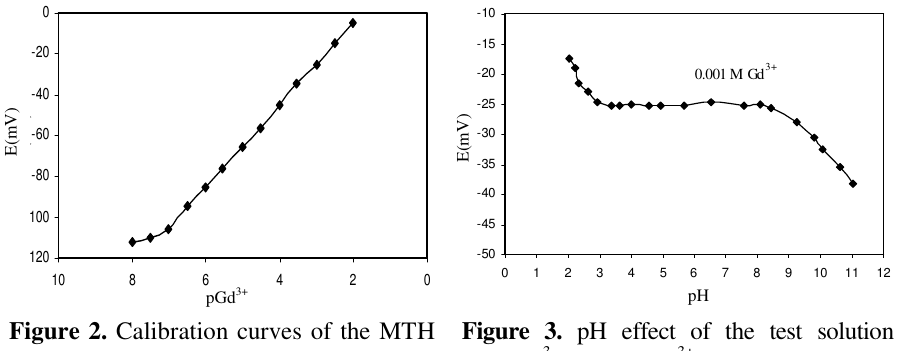
Figure 2. Calibration curves of the MTH -based gadolinium electrode